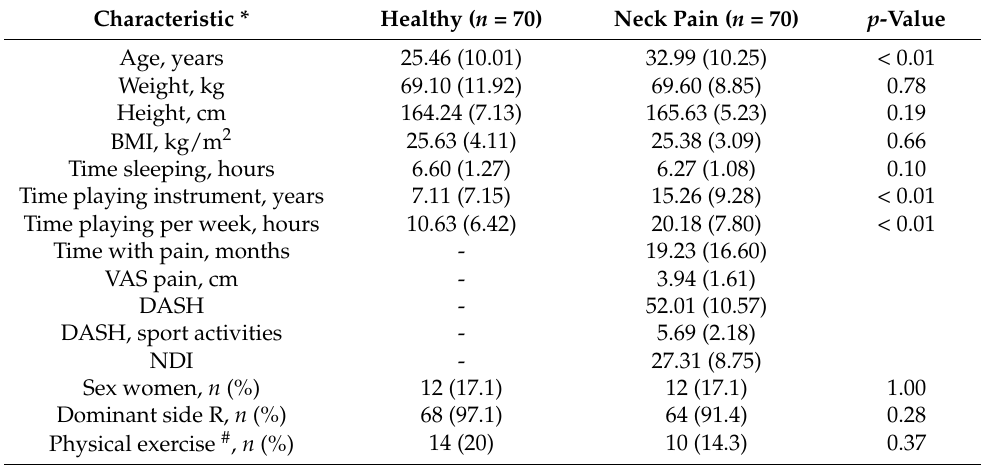
Table 1. Characteristics of the subjects ( n =